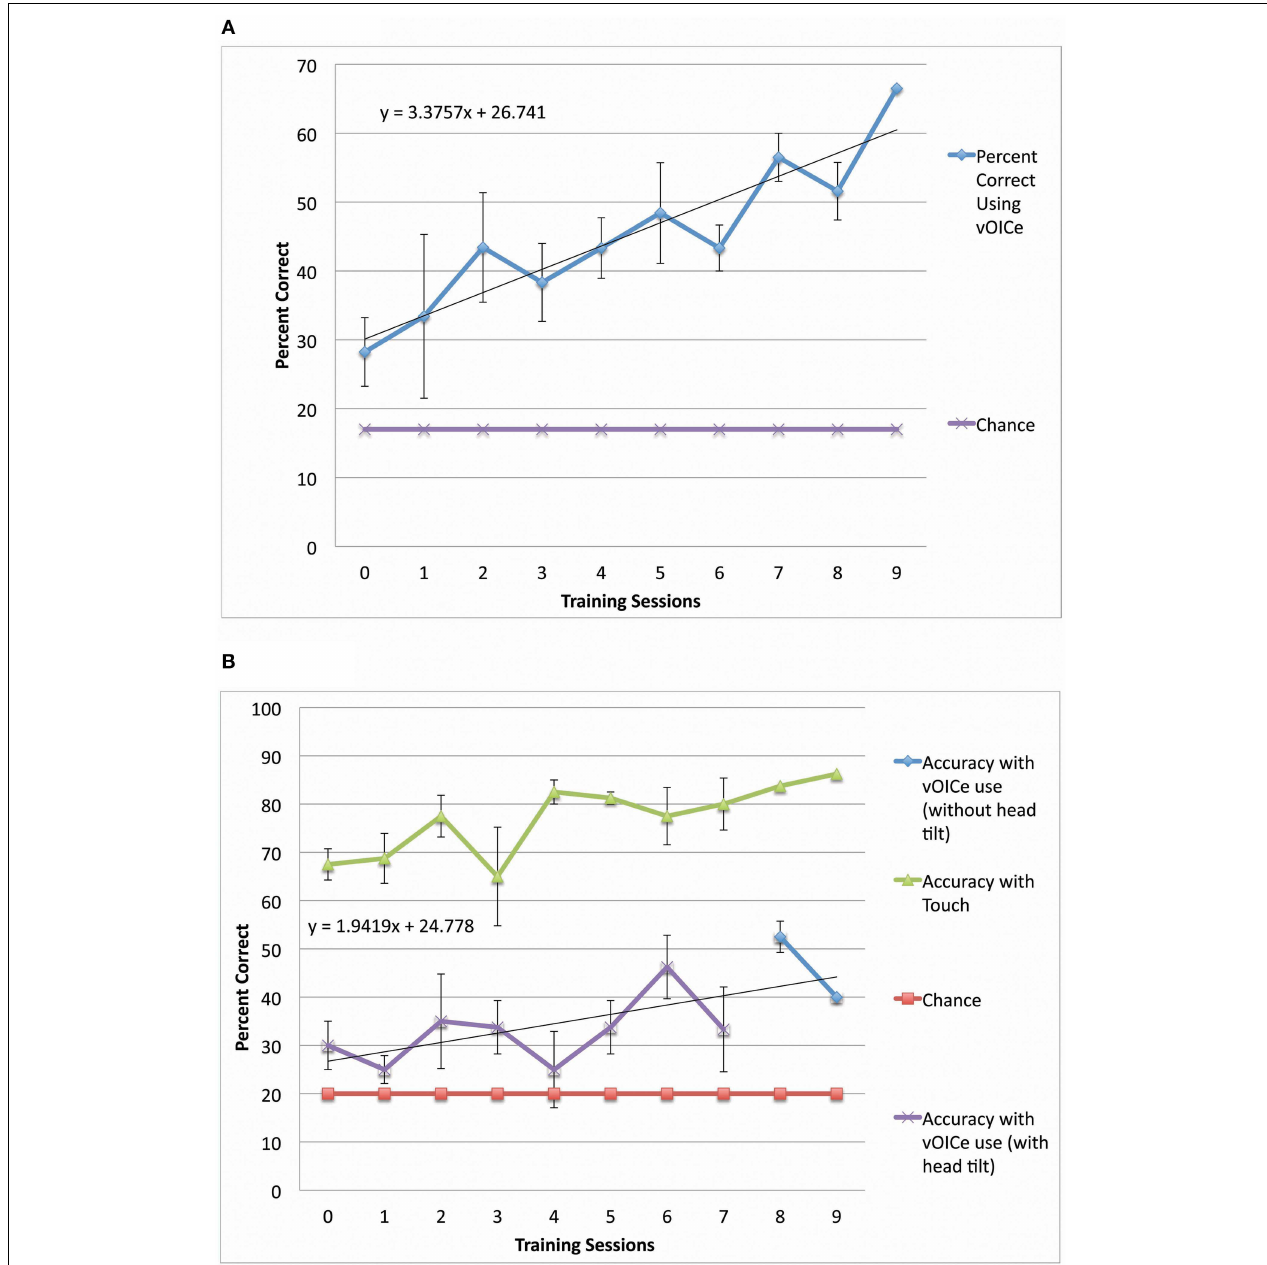
FIGURE 3 | Performance in both constancy tasks by blind subjects ( N = 4 ). (A) Plots the task performance of orientation constancy as a function of the number of training sessions in the blind participants only